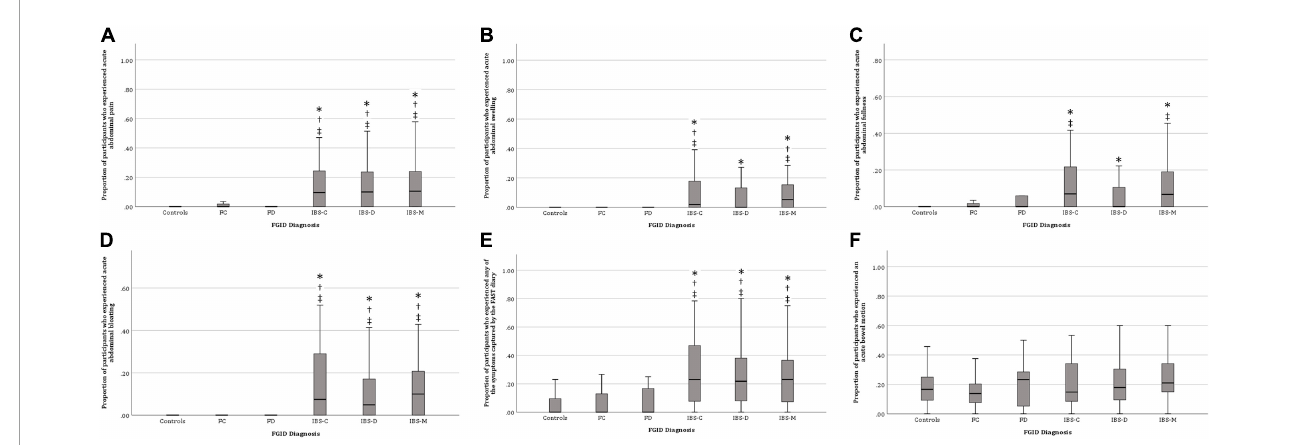
FIGURE1 Proportion of participants who experienced post-prandial bowel symptoms. (A) Abdominal pain, (B) Abdominal swelling, (C) Abdominal fullness, (D) Abdominal bloating, (E) Any gastrointestinal symptom, and (F) Bowel motion. IBS, irritable bowel syndrome; IBS-D, diarrhea predominant IBS; IBS-C, constipation predominant IBS; IBS-M, mixed phenotype predominant IBS; FD, functional diarrhea; FC, functional constipation. * p < 0.05 compared with controls, † p < 0.05 compared to FC, ‡ p < 0.05 compared to FD.